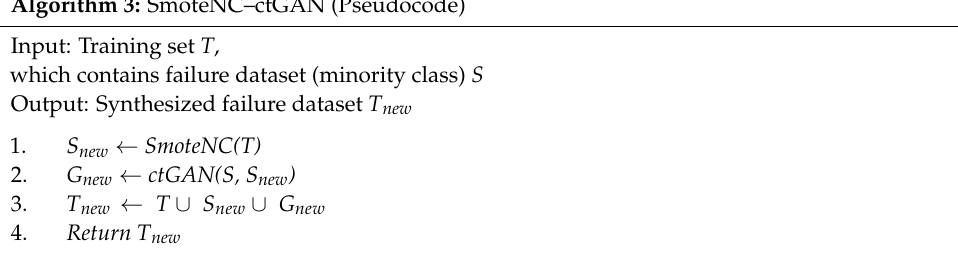
Algorithm 3: SmoteNC–ctGAN